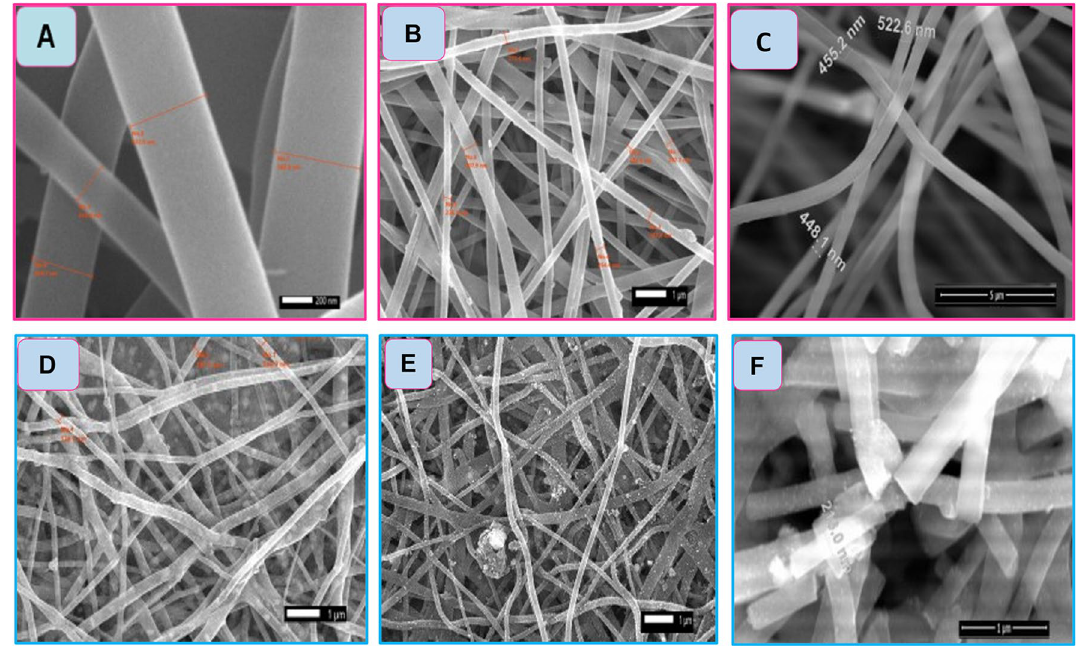
Figure 1. SEM images of ( A ) Ni 17 Pt 3% /CNFs, ( B ) Ni 14 Pt 3 Cr 3 CNFs, ( C ) Ni 11 Pt 3% Cr 6% /CNFs before carbonization, ( D )